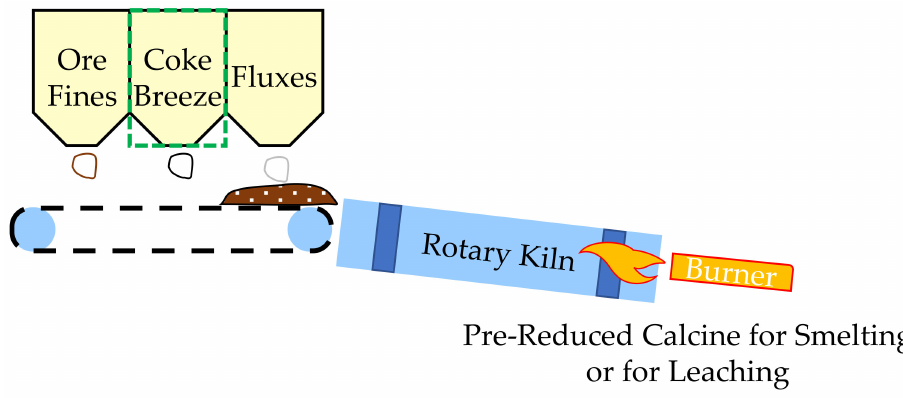
Figure 7. Schematic calcination process.